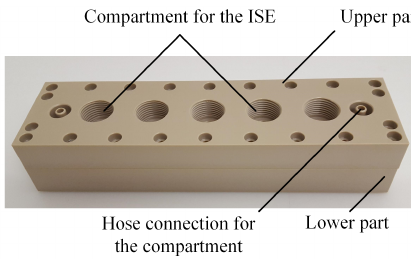
Figure 8. Photo of the measuring chamber consisting of two parts made of PEEK. The lower part has the hose connections for the extracorporeal circuit. The upper part contains the compartment for the ISEs and the hose connections for the compartment.